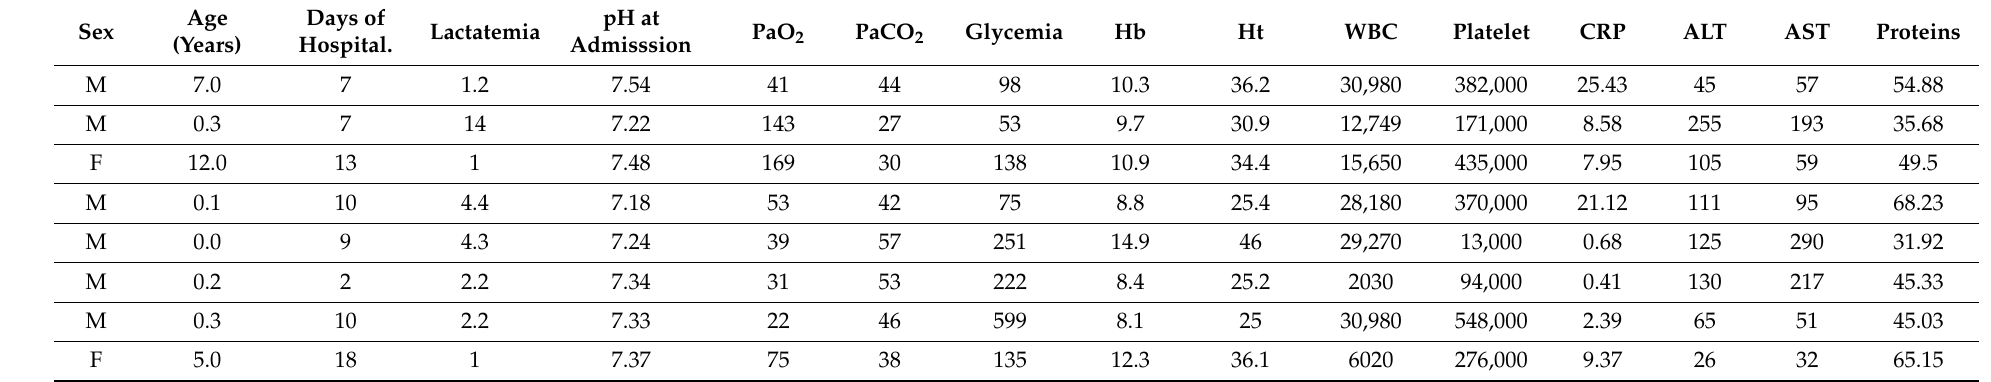
Table 3. Descriptive statistics for the deceased